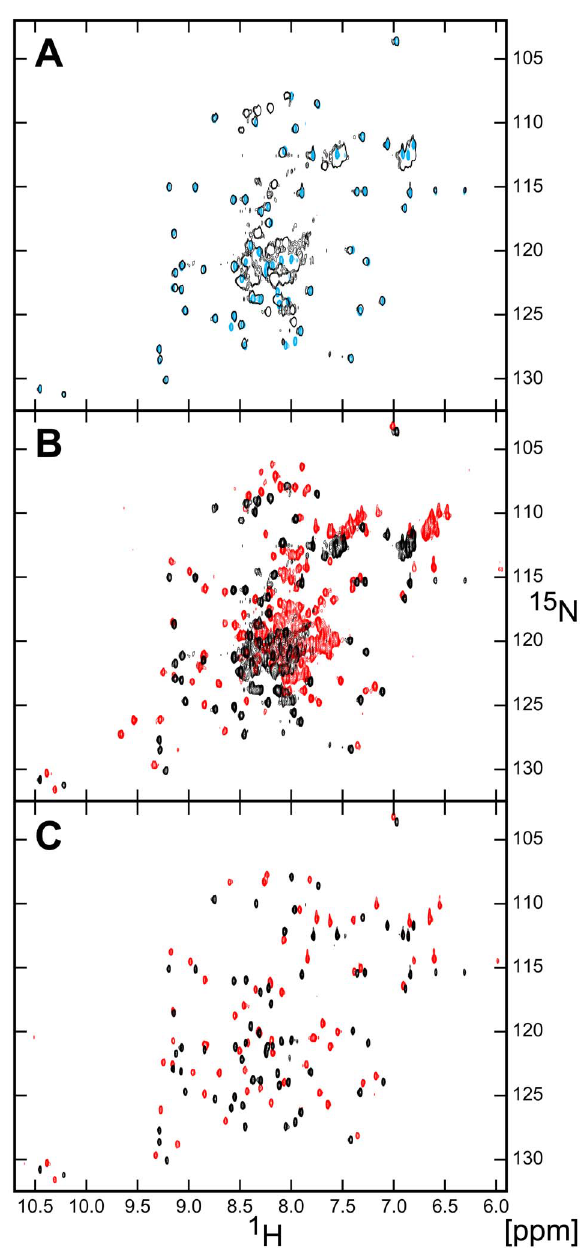
Figure 4. Overlay of the 2D 1 H- 15 N HSQC spectra of 15 N-labeled GB1-DAPk-DD and 15 N-labeled GB1 in the presence and absence of TFE. (A) Overlay of 15 N-labeled GB1-DAPk-DD (black) and 15 N-labeled GB1 (cyan) spectra shows that the chemical shifts of the resonances arising from the GB1 residues in both constructs have near identical chemical shifts, therefore indicating that there are negligible contacts between GB1 and the DAPk-DD in the GB1-DAPk- DD construct. (B) Overlay of HSQC spectra of 15 N-labeled GB1-DAPk-DD in the absence (black) and presence (red) of 40% (v/v) TFE. The majority of the dispersed, intense signals arise from GB1. The unresolved resonances in the center of the spectrum arise from the DD and indicate that the domain lacks a tertiary fold. The addition of TFE leads to a general decrease in resonance line widths and a minor increase in resonance dispersion, suggesting that TFE aids the formation of secondary structure elements of the DD, but the domain lacks a compact DD fold. (C) Overlay of HSQC spectra of 15 N-labeled GB1 in the absence (black) and presence (red) of 40% TFE (v/v).